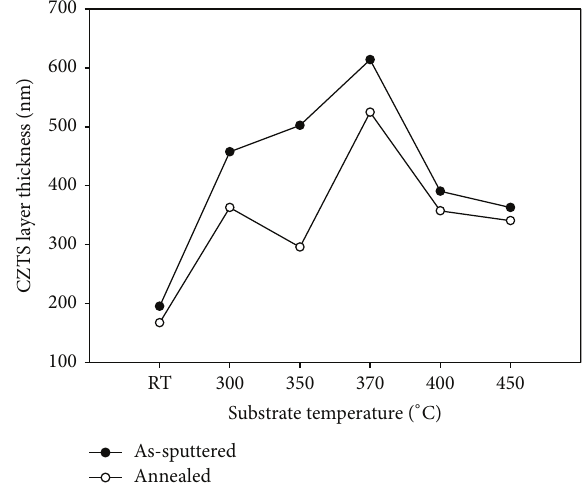
Figure 9: Thickness variation of as-sputtered and annealed CZTS